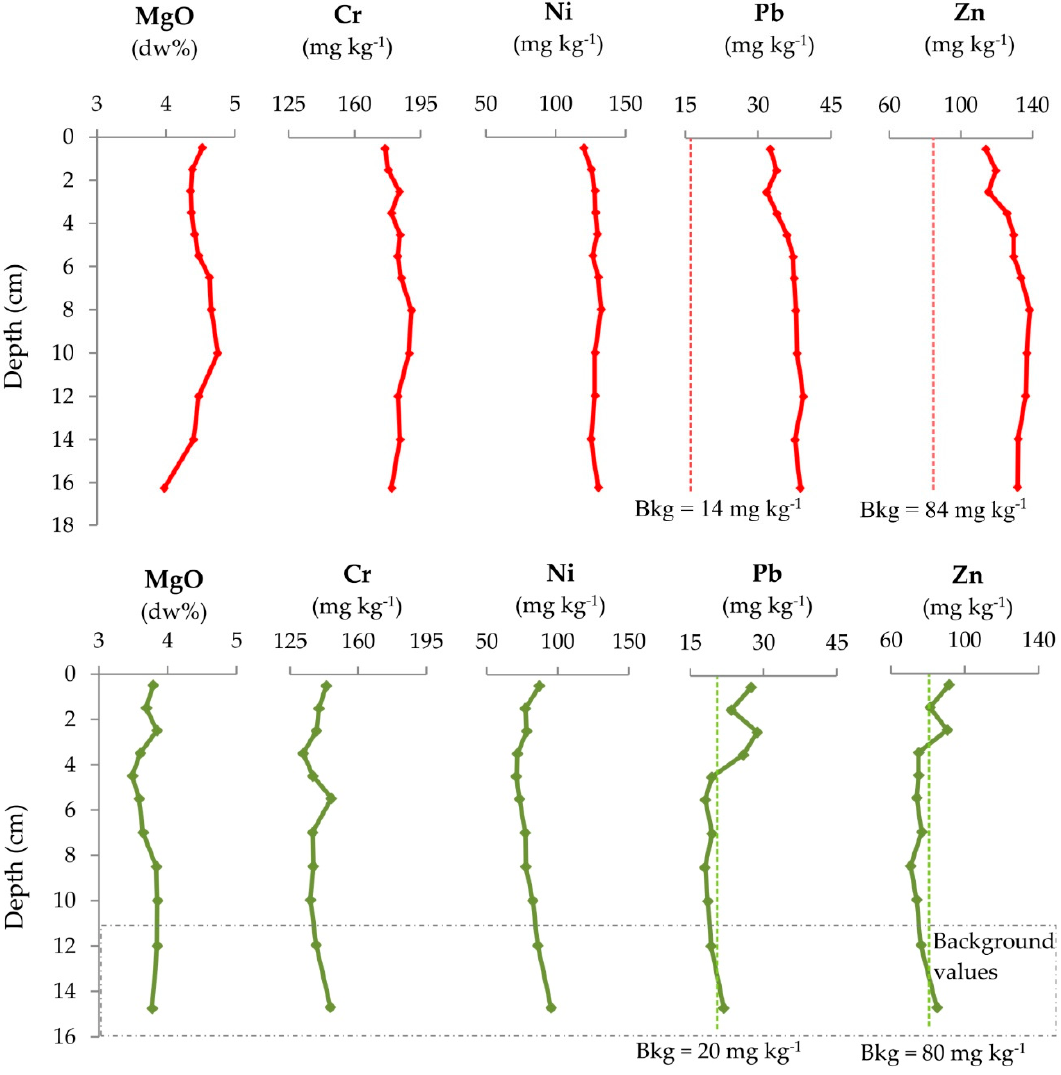
Figure 5. Depth profiles of selected major (MgO) and trace elements (Cr, Ni, Pb and Zn) in S1 (red line) and E1 (green line) sediment cores (ANOC ‐ 16).